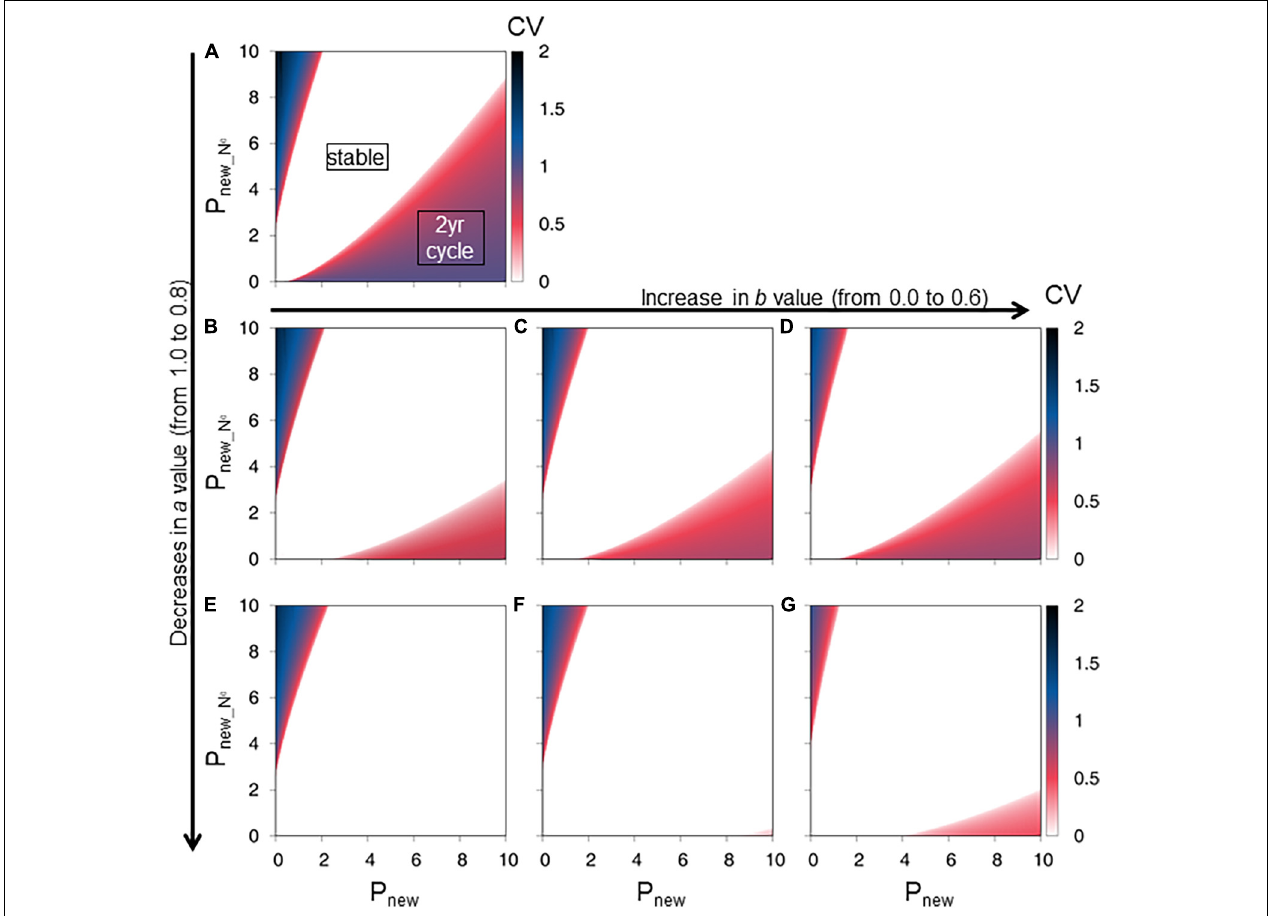
FIGURE 5 | Effect of belowground carbon storage on new shoot production. The figures show the final state coefficient of variation (CV) values. The parameter settings of upper left (A) are identical to those of Figure 3A . The other figures show the final state CV values from six sets of parameters a and b . The parameter a ranged from 1.0 [upper panel; (A) ], 0.9 [middle panels; (B–D) ], to 0.8 [lower panels; (E–G) ]. The parameter b ranged from 0.0 [left column; (A,B,E) ], 0.3 [central columns; (C,F) ], to 0.6 [right columns; (D,G) ]. The color gradation bars represent the CV.